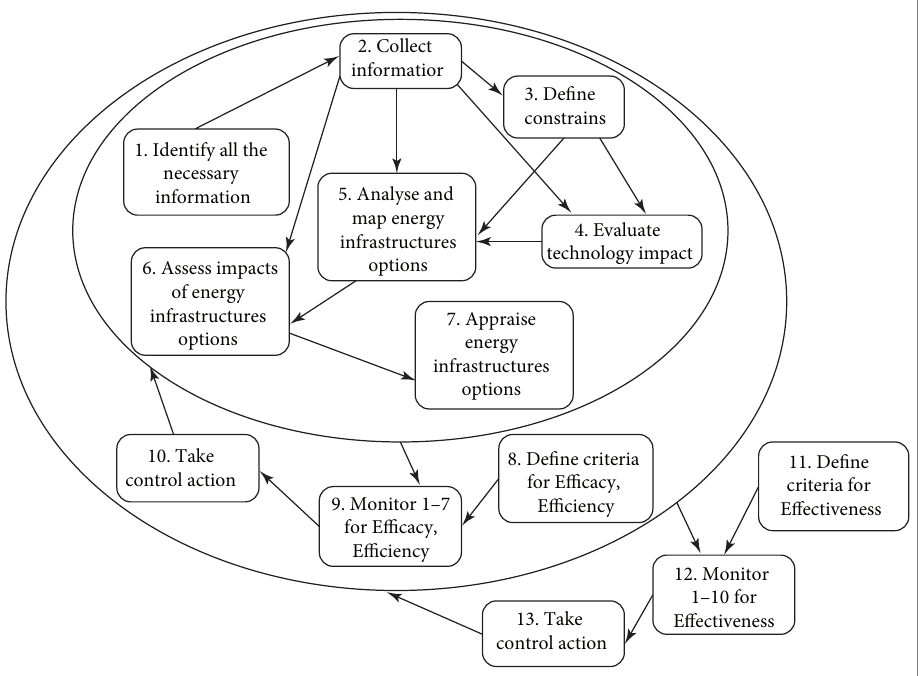
Fig. 2. The conceptual model of the